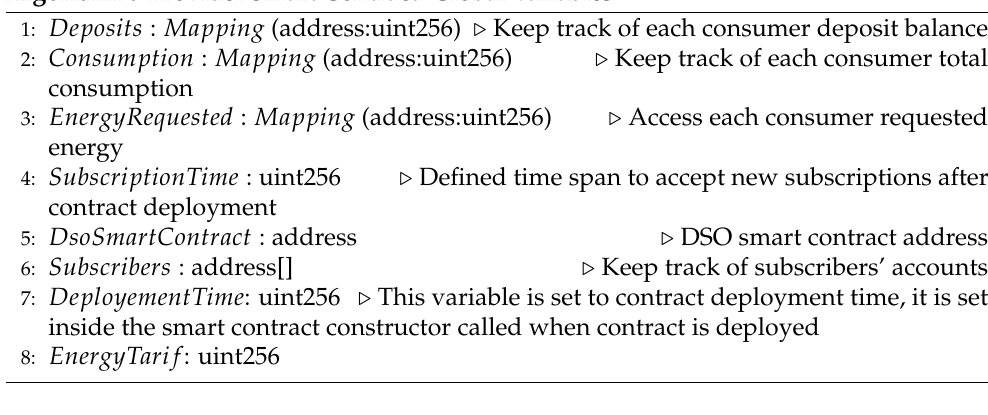
Algorithm 10 Provider Smart Contract